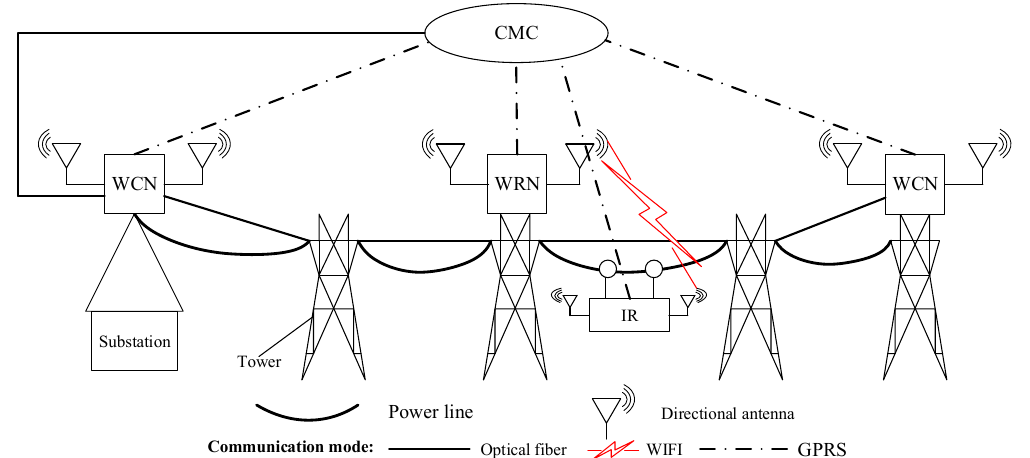
Figure 2. The hybrid hierarchical network communication architecture of the robot hybrid hierarchical network (RHHN).